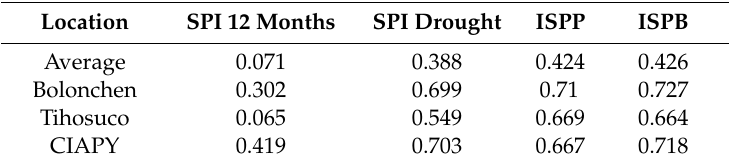
Table 3. Correlation coe ffi cients between normalized di ff erence vegetation index (NDVI) data and drought indices